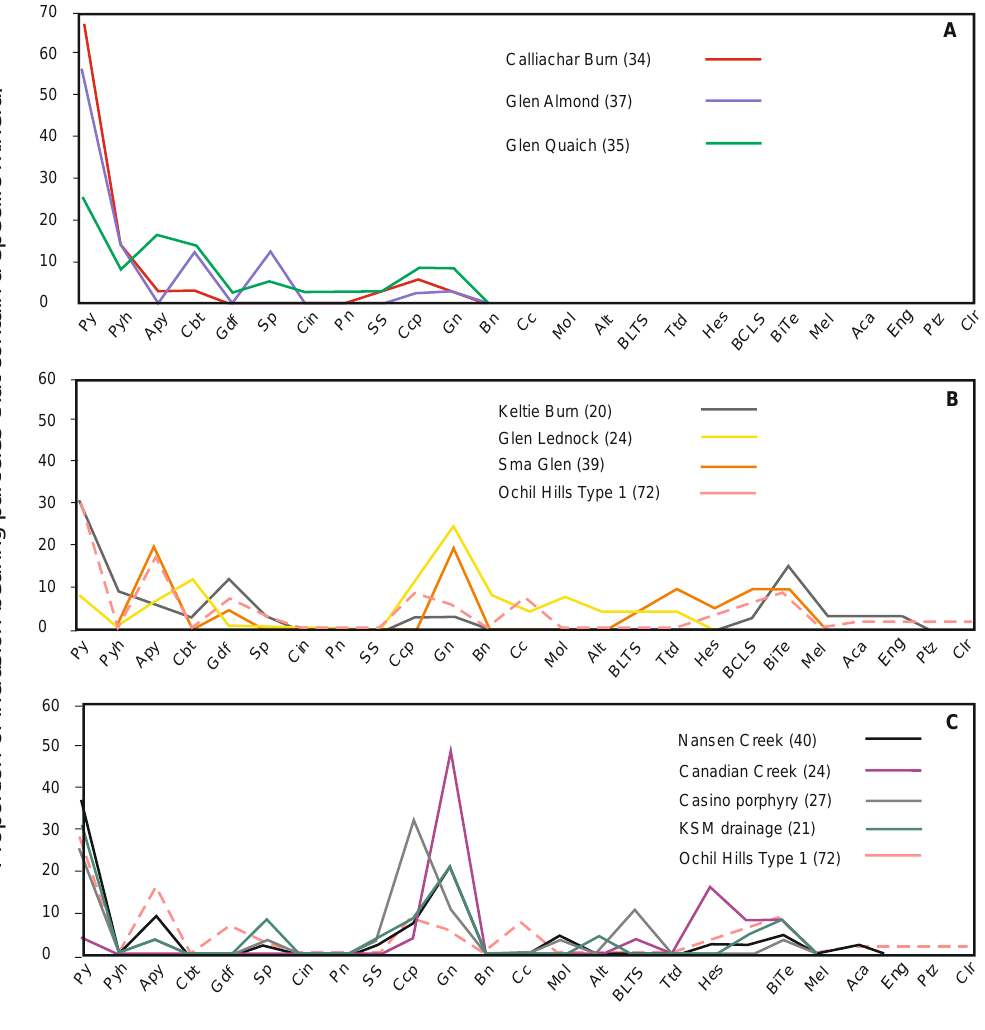
Figure 7. Spider plots showing inclusion suites. ( A ) Sample populations within Group 1 showing similar, restricted inclusion signatures (Calliachar Burn, the River Almond, Glen Quaich); ( B ) Sample populations within Group 2, showing a more variable signature with a wider range of inclusion mineralogy (Sma Glen, Keltie Burn, Glen Lednock) together with the signature of the gold from the Ochil Hills [56]. ( C ) Comparison of inclusion signatures in gold from Canadian porphyry and epithermal localities, [10] with those of the most widespread gold type from Ochil Hills, Scotland [32]. ‘KSM’ = ‘Kerr -Sulphuretes- Mitchell’ .